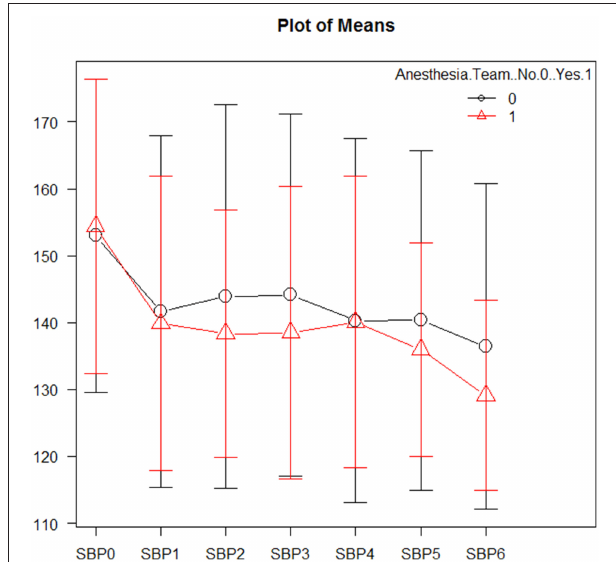
FIGURE 1 | Mean systolic blood pressures during mechanical thrombectomy. Patients in the sedation-trained provider group are represented in black, and patients in the anesthesia team group are represented in red. SBP0 represents systolic blood pressure on arrival to the interventional lab. SBP1-3 are measurements taken prior to revascularization, while SBP4-6 are measurements taken after